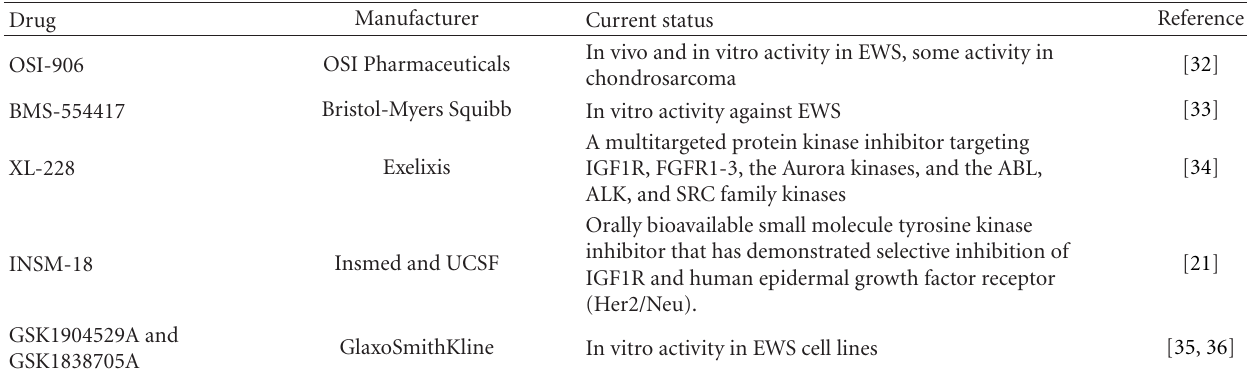
Table 2: Small-molecule inhibitors of insulin-like growth factor 1 receptor